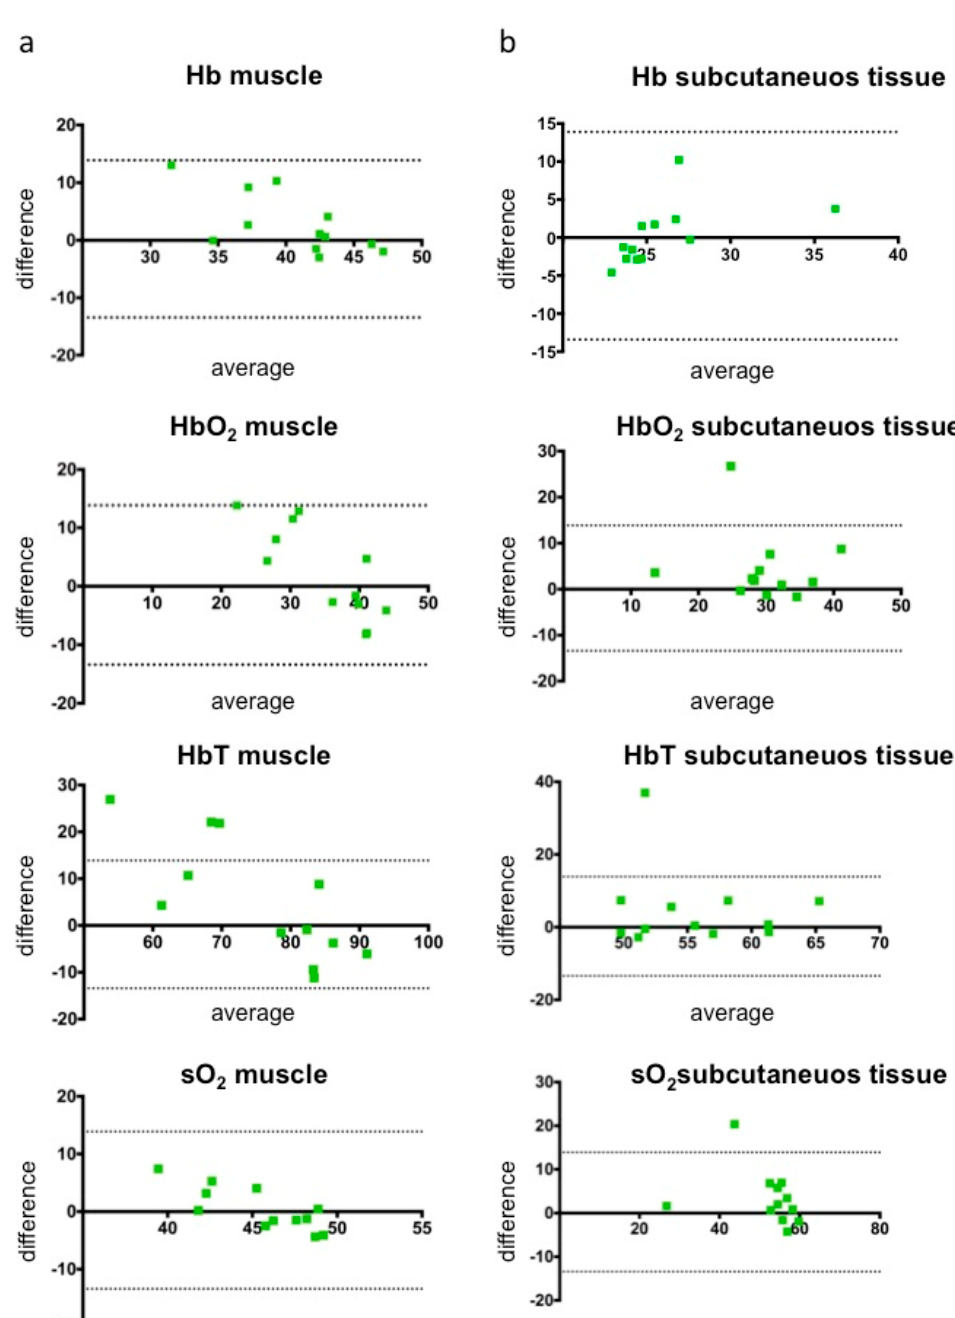
Figure 2. Bland Altman Plots illustrating absolute differences and averages between the mean values of first and second measurements acquired by the same examiner in healthy individuals ( n = 3, 12 measurements, 95% limits of agreement are indicated by the dashed lines). For deoxygenated (Hb), oxygenated (HbO 2 ) and total hemoglobin (HbT), as well as oxygen saturation in muscular ( a ) and subcutaneous fat tissue ( b ), good reproducibility of the calculated values can be detected, indicating a low intraobserver variability.